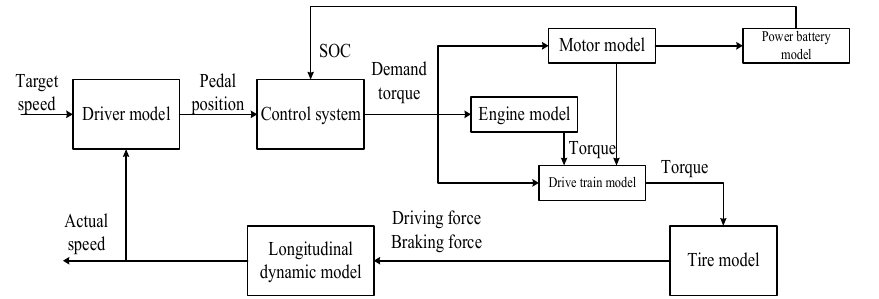
Figure 1. Basic structure of forward simulation analysis platform.